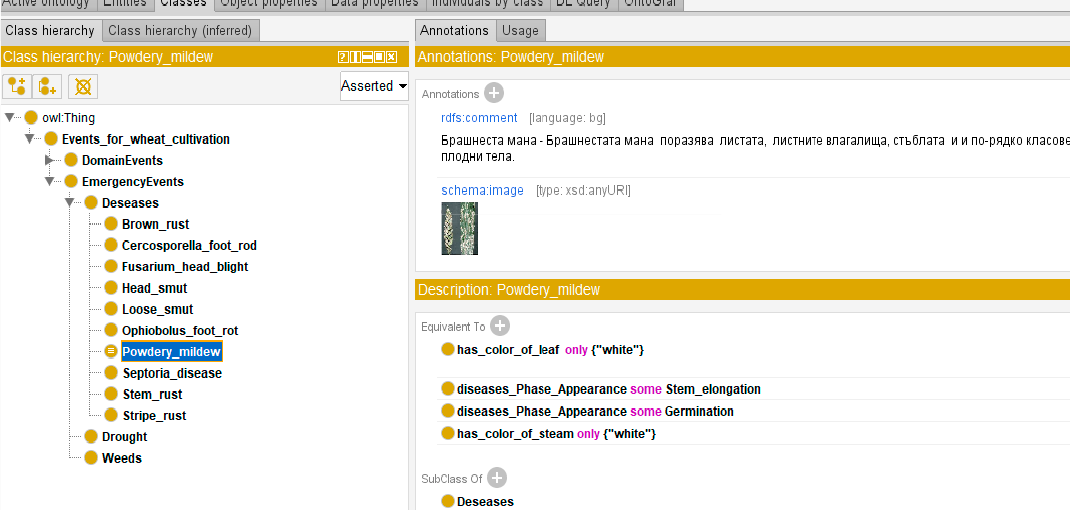
Figure 15. The Equivalent To axiom for the Powdery mildew disease.